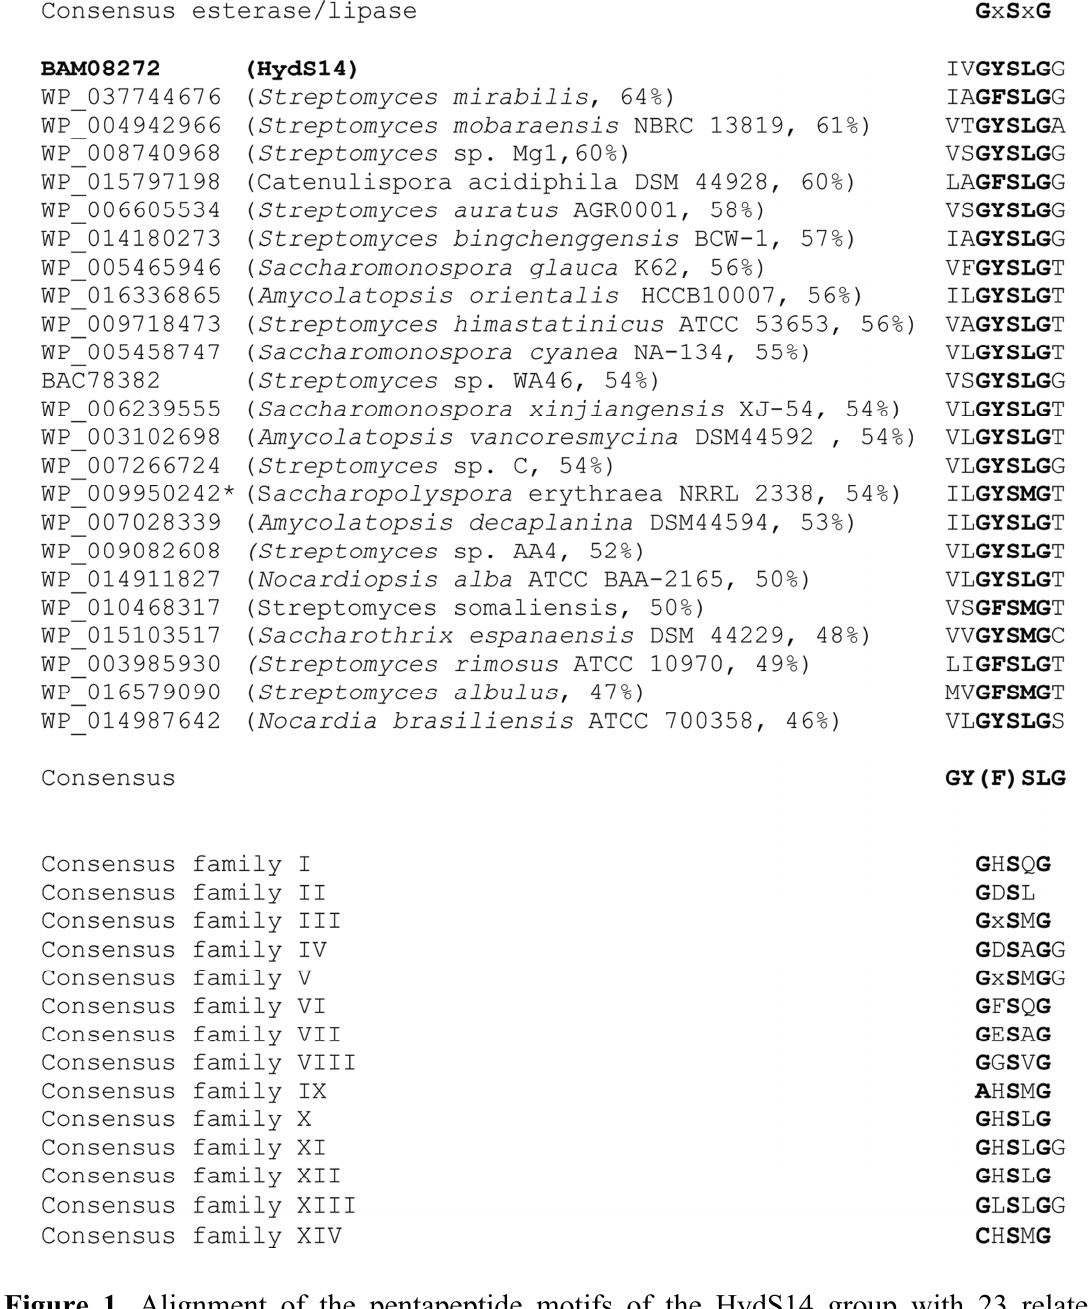
Figure 1. Alignment of the pentapeptide motifs of the HydS14 group with 23 related enzymes and the consensus sequences of 14 known esterase/lipase families Asterisks indicate 3-oxoadipate enol-lactone hydrolases and the other enzymes are α / β -hydrolases. Conserved regions of the pentapeptide motif are shown in